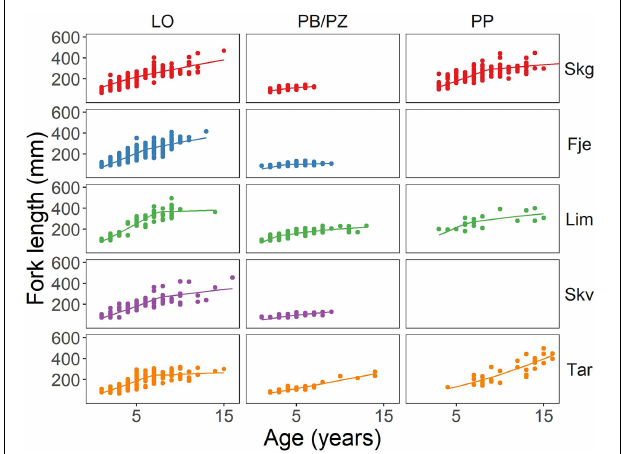
FIGURE 3 | Biphasic growth model-based length at age estimates of three Arctic charr morphs in the studied lakes. The point of inflection in the model indicates the age where energy is diverted from somatic growth to reproductive investment. Skg, Skogsfjordvatn; Fje, Fjellfrøsvatn; Lim, Limingen; Skv, Skøvatn; and Tar, Tårnvatn.